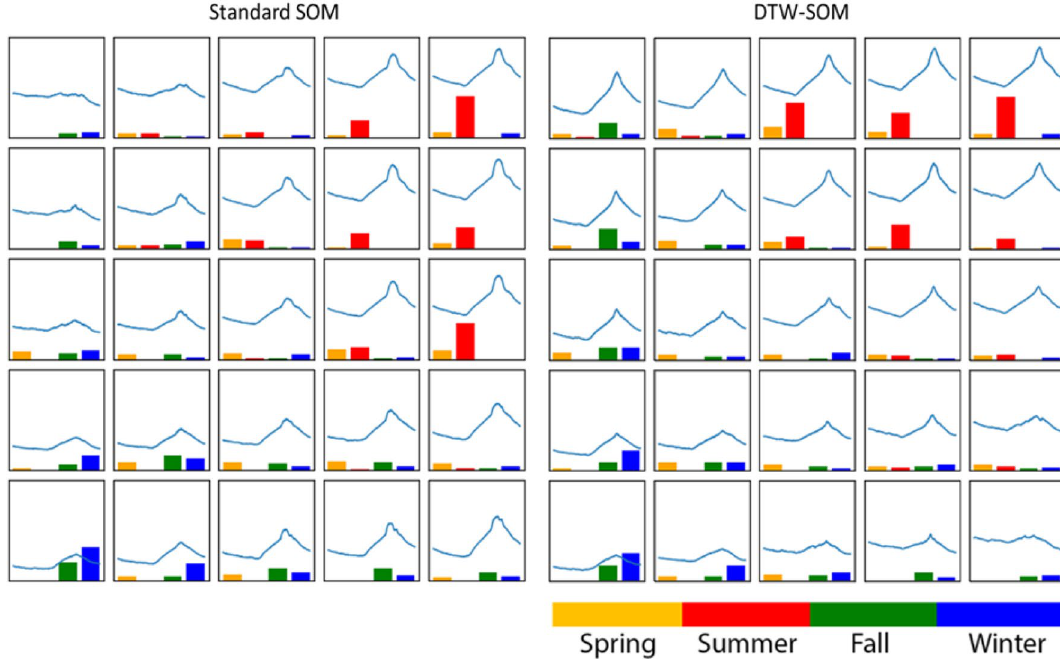
Figure 6. Diurnal patterns in outdoor temperature identified using standard SOM (left) and DTW-SOM (right). Each cell represents a neuron, the curved line represents its final weights, and the bar plot indicates the distribution by season of the input observations best matching that neuron.